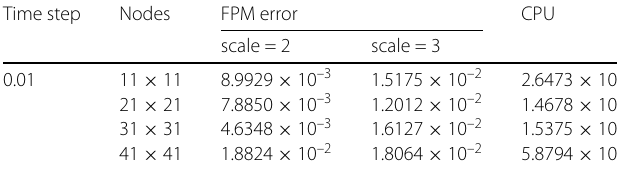
Table 9 The error and computing time of FPM Time step Nodes FPM error CPU